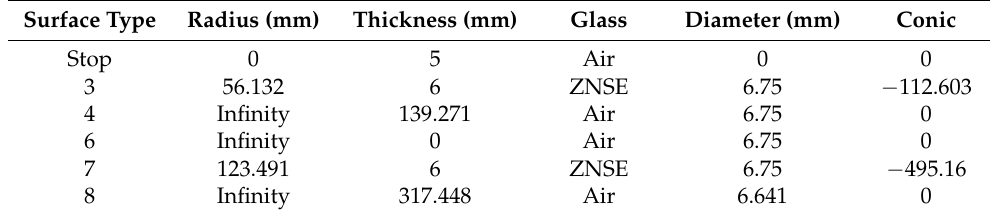
Table 1. Structural parameters of the combination optical system.